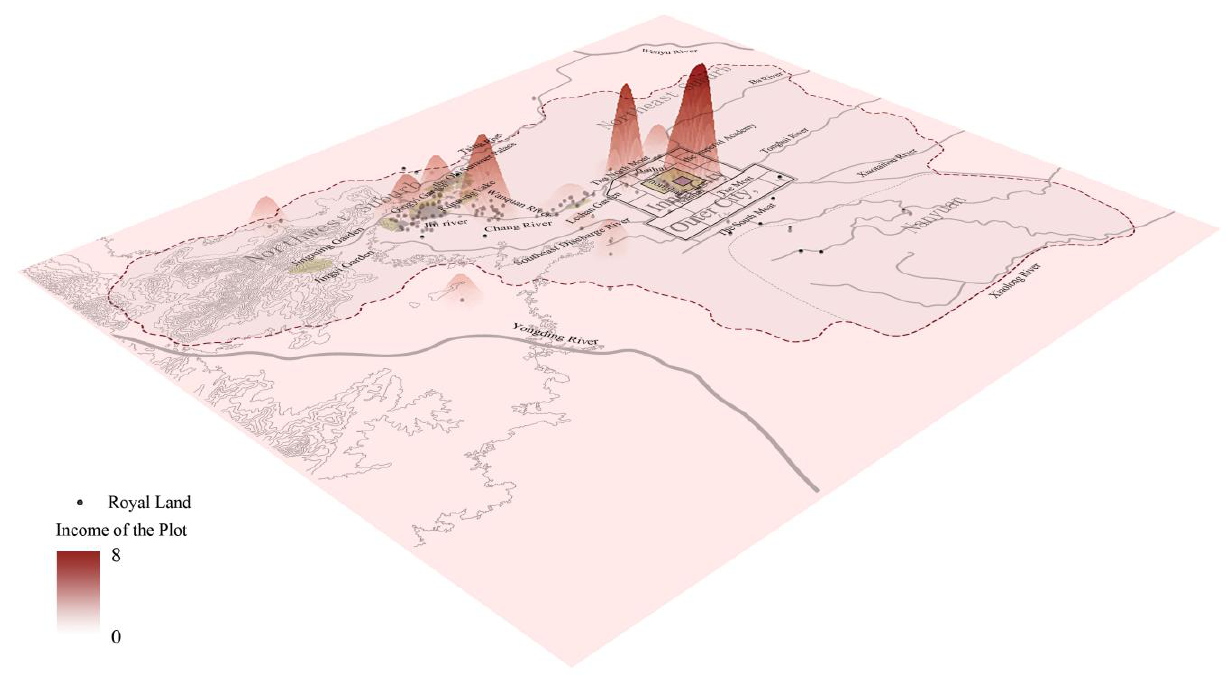
Figure 19. Spatial 3D analysis of plot income.